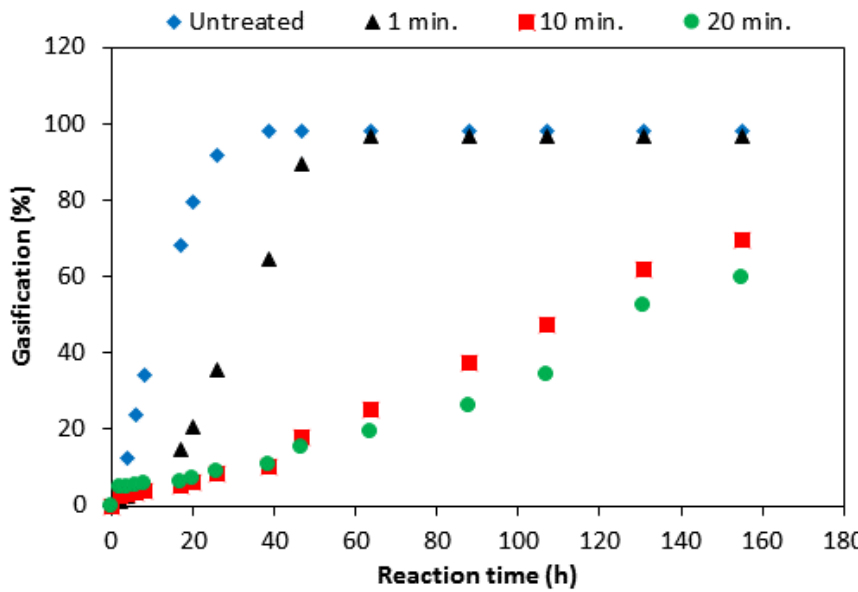
Figure 3. Gasification vs. reaction time during gasification for a series of samples with different impregnation times.